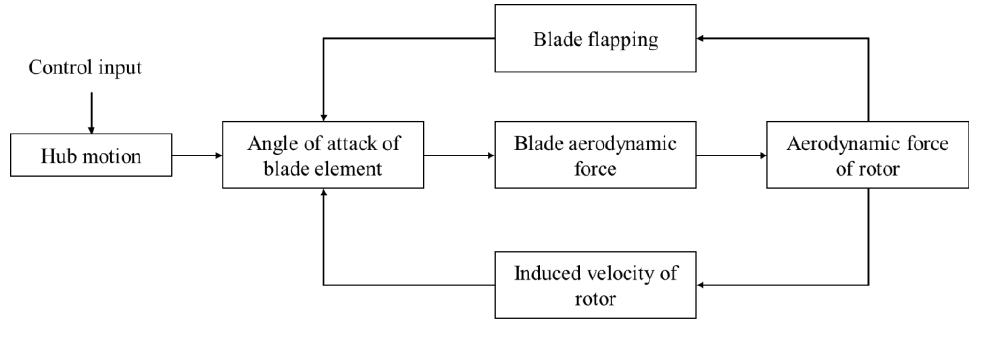
Figure 3. Diagram of solving the rotor model.